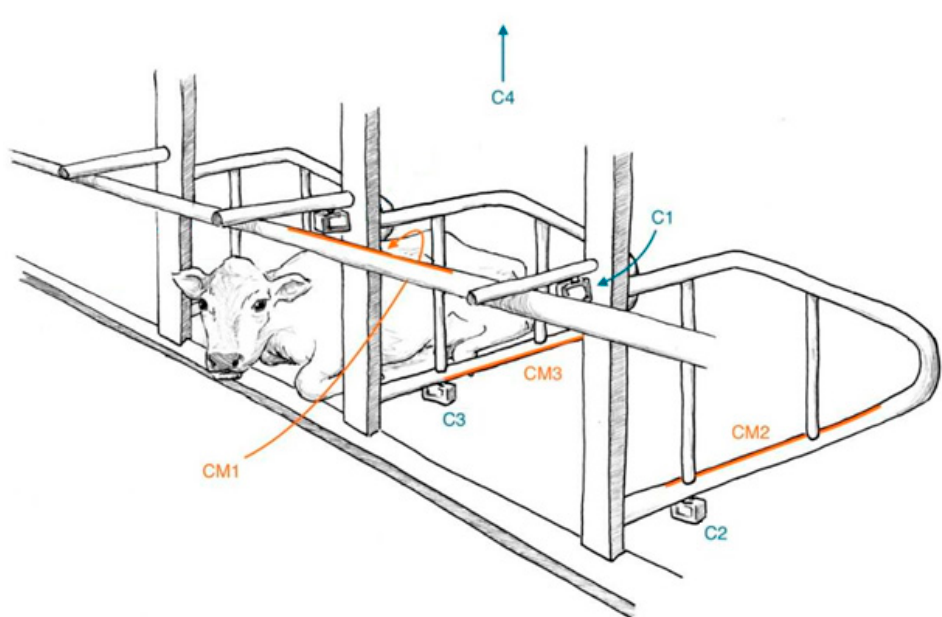
Figure 2. Illustration depicting the video camera and CM placement for a single tie-stall in accordance with study design. Three separate CM (orange) were used for each stall, with CM1 affixed to the neck rail, CM2 to the right divider, and CM3 to the left divider. Three video cameras (blue) were used to provide visual observation of each CM, with C1 used for the neck rail, C2 for the right divider, and C3 for the left divider. An additional video camera (C4) was included to provide an overhead view of each stall for monitoring cow position.